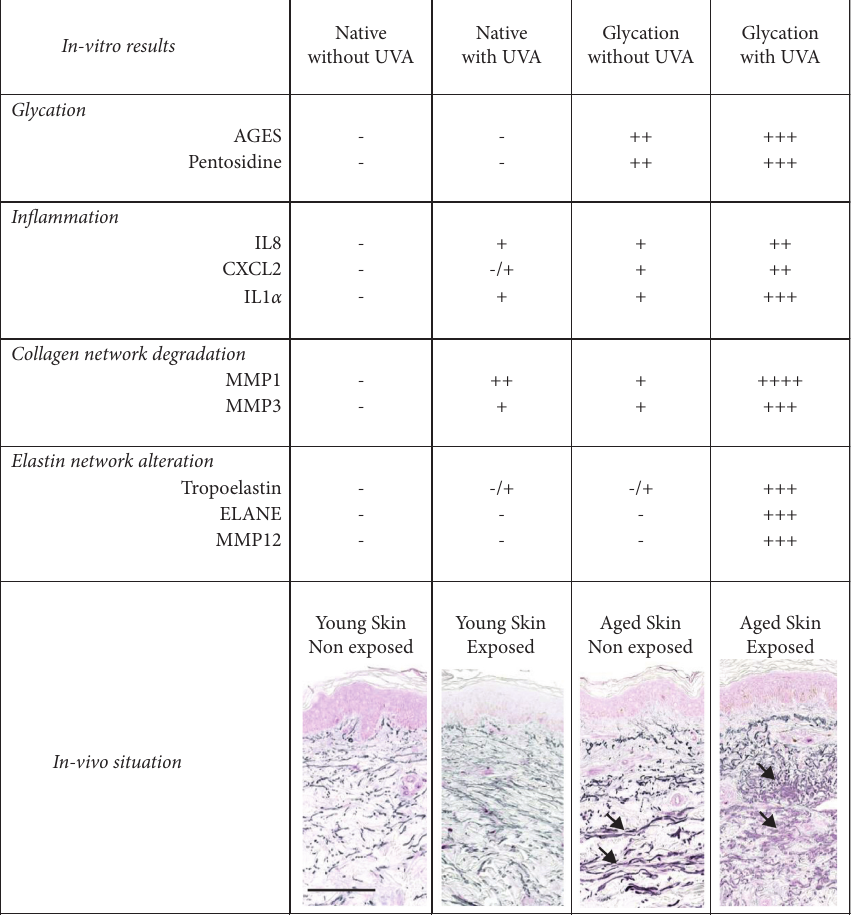
Figure 5: In vitro and in vivo observations related with possible deleterious effect of glycation combined with the UVA irradiation. Elastin (grey) and pentosidine (pink) immunostainings of different forearm human skin. Note that positive labelling for elastin and pentosidine (as shown by the arrow) increased with age and photoexposure (bar � 100 µ m). The main changes observed in human skin in function of age and photoexposure that could partly be explained by transposition with our in vitro